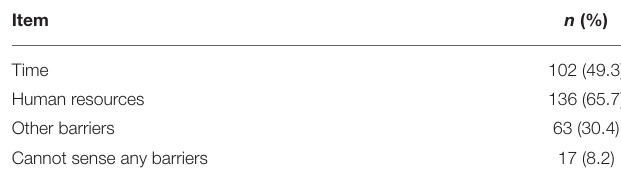
TABLE 7 | Barriers to implementing siblings support (multiple